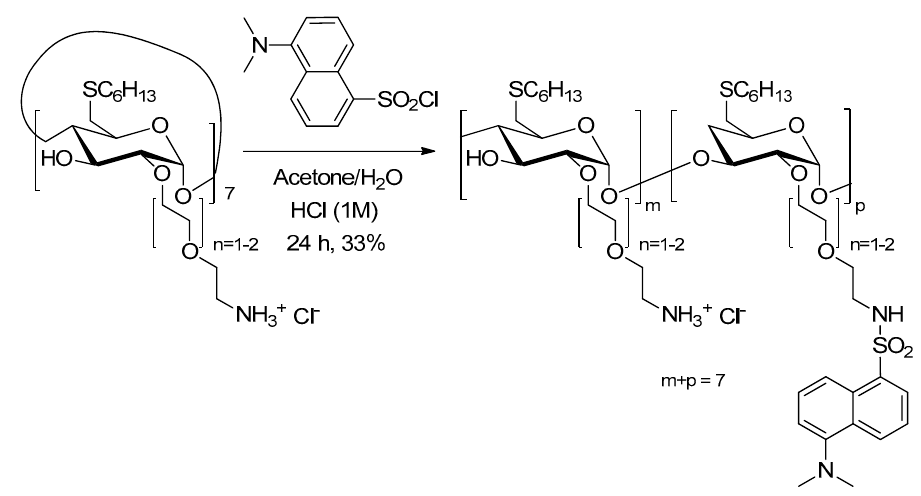
Figure 37. Functionalization of SC 6 - β -CD-NH 2 with the dansyl fluorophore.